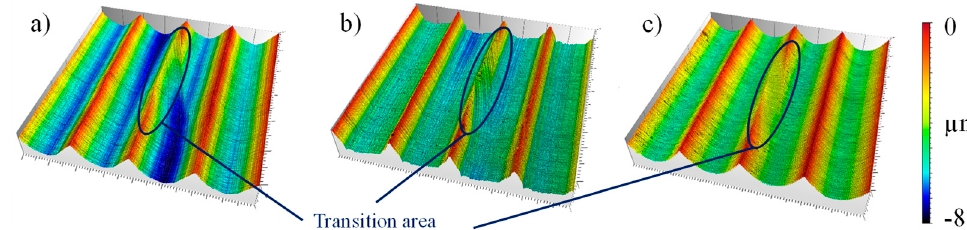
Figure 8. Comparison of the shape of the transition areas of hardened ( a ) and unhardened ( b ) steel and brass ( c ) with a dwell value of n v = 2; each field is 800 µ m in width and 6 ◦ in length.